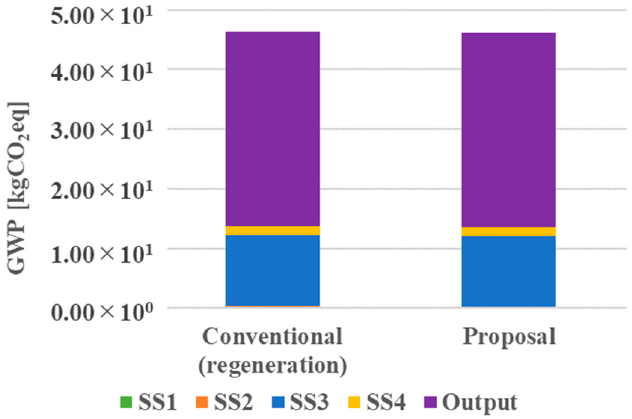
Figure 10. GWP results in the conventional (regeneration) and proposed cases.